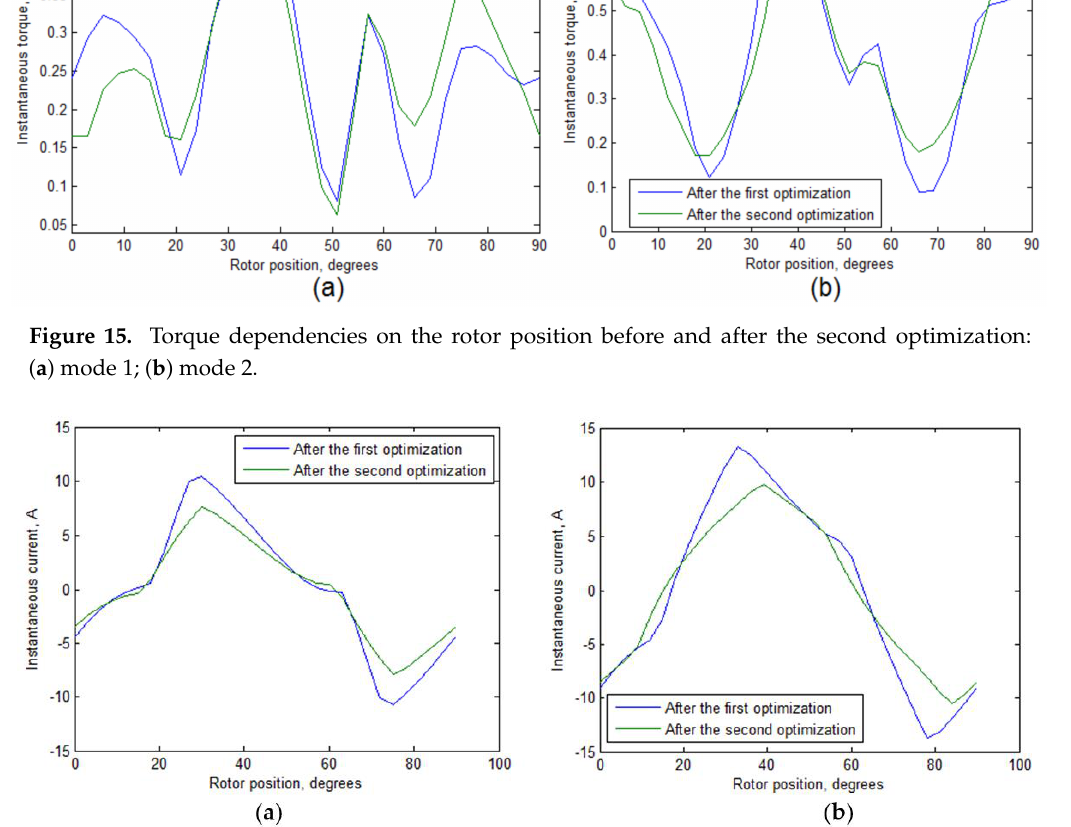
Figure 16. Current dependencies on the rotor position before and after the second optimization: ( a ) mode 1; ( b ) mode 2.